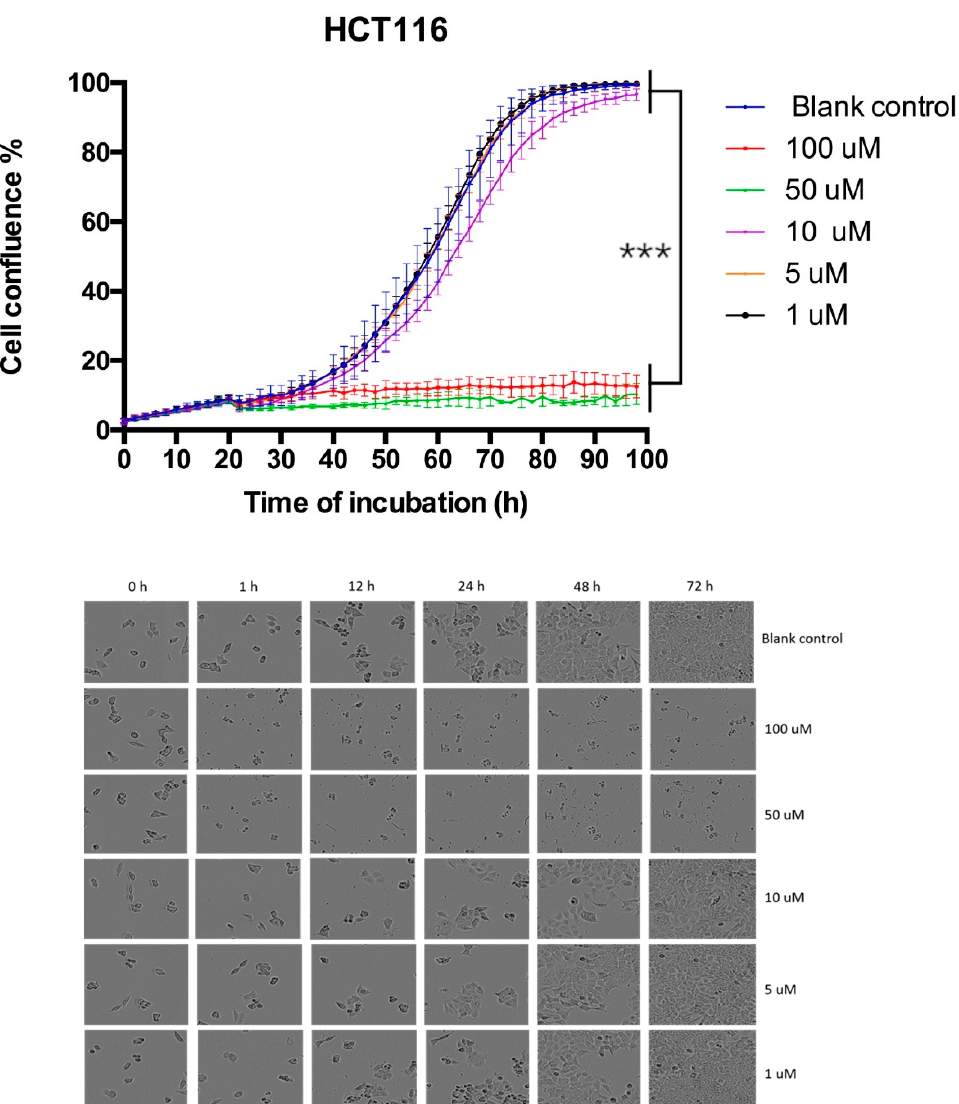
Figure 4. Growth curve of HCT116 treated with gradient concentrations of the peptide LFB. Note that proliferation of HCT116 cells were inhibited in a dose-dependent manner with peptide treatment, and the blank control group was treated with equal amounts of PBS. The visualized results were randomly picked from 25 pictures, which were caught continually for every well. The levels of significance are * p < 0.05; ** p < 0.01; *** p < 0.001; **** p < 0.001.